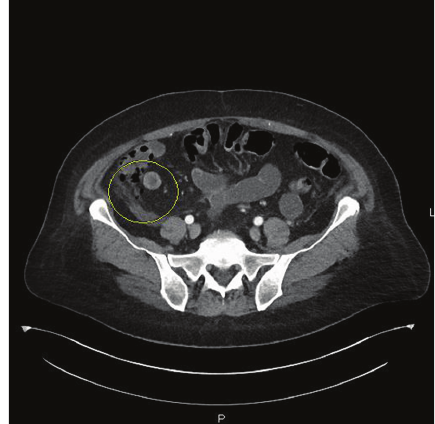
Figure2:Contrast-enhancedCTabdomenshowingwallthickening in the ascending colon with pericolonic stranding pattern and adjacent tiny foci of free air (circle) suggestive of colon